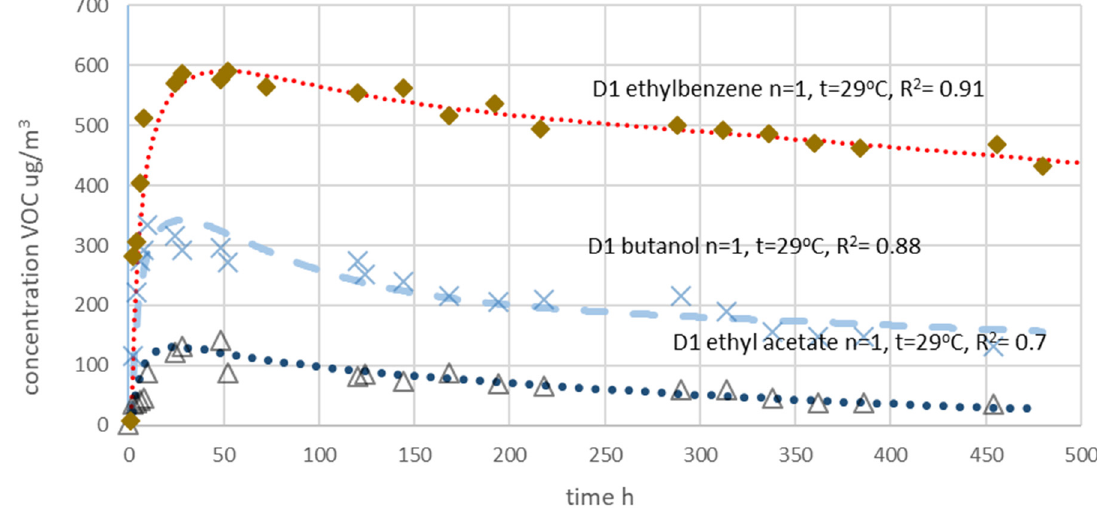
Figure 15. The selected VOC emission profiles from D1 floor systems (tested for 480 h) for the air change rates n = 1 h − 1 at 29 ◦ C (and RH = 50%) in the test chamber, including ethylbenzene, butanol and ethyl acetate (D1 sample is a floor system made of: polyurethane solvent primer and polyurethane adhesive (Table 2)).